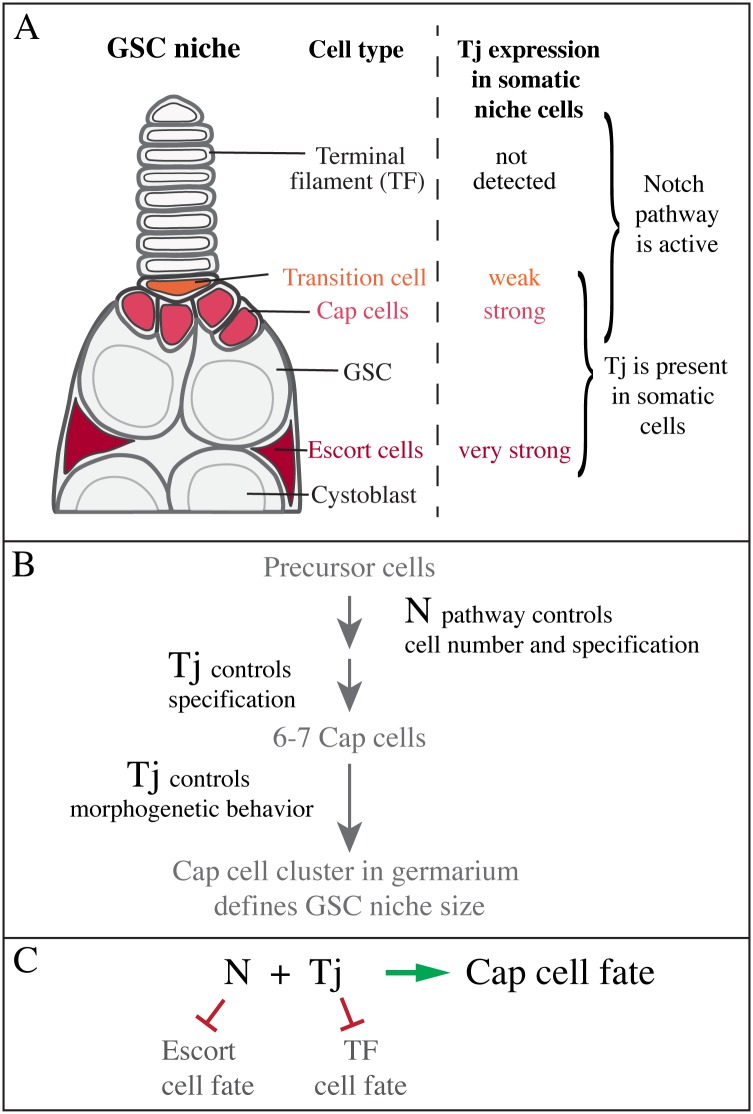
Model of Tj function in the GSC niche.(A) Tj is expressed at different levels in the somatic cell types of the GSC niche. Cap cells contain both Tj and activated N in contrast to TF and escort cells. (B,C) The combined action of Tj and N is required to establish the cap cell fate.